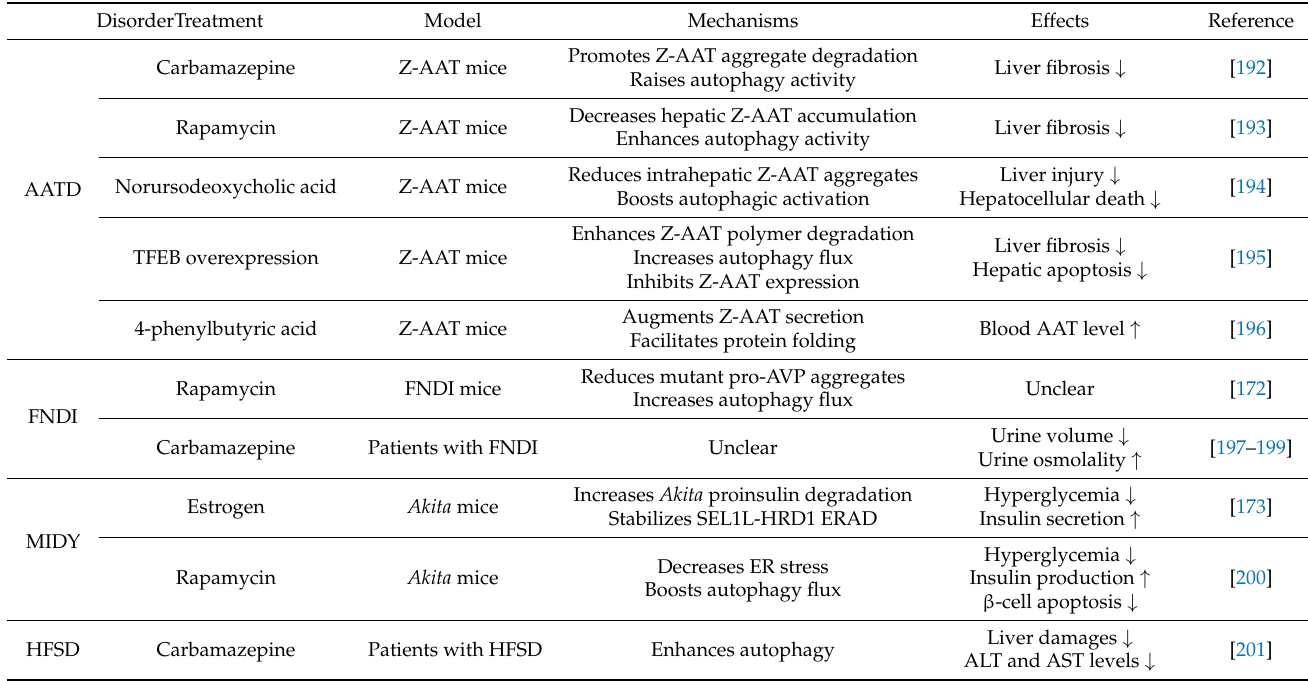
Table 2. Potential therapeutic approaches for selective ER storage